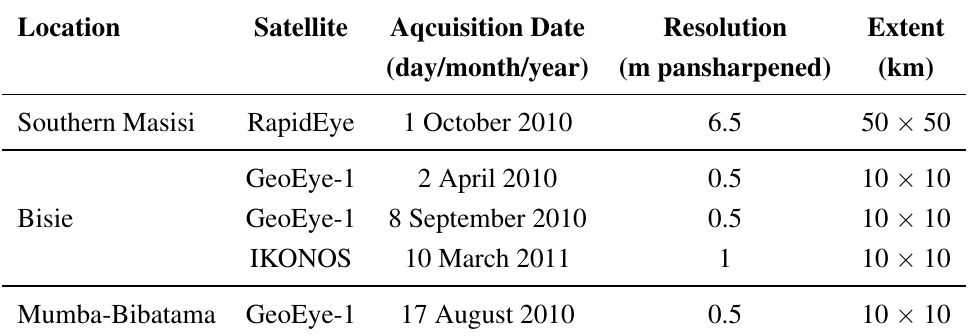
Table 1. Satellite imagery 1